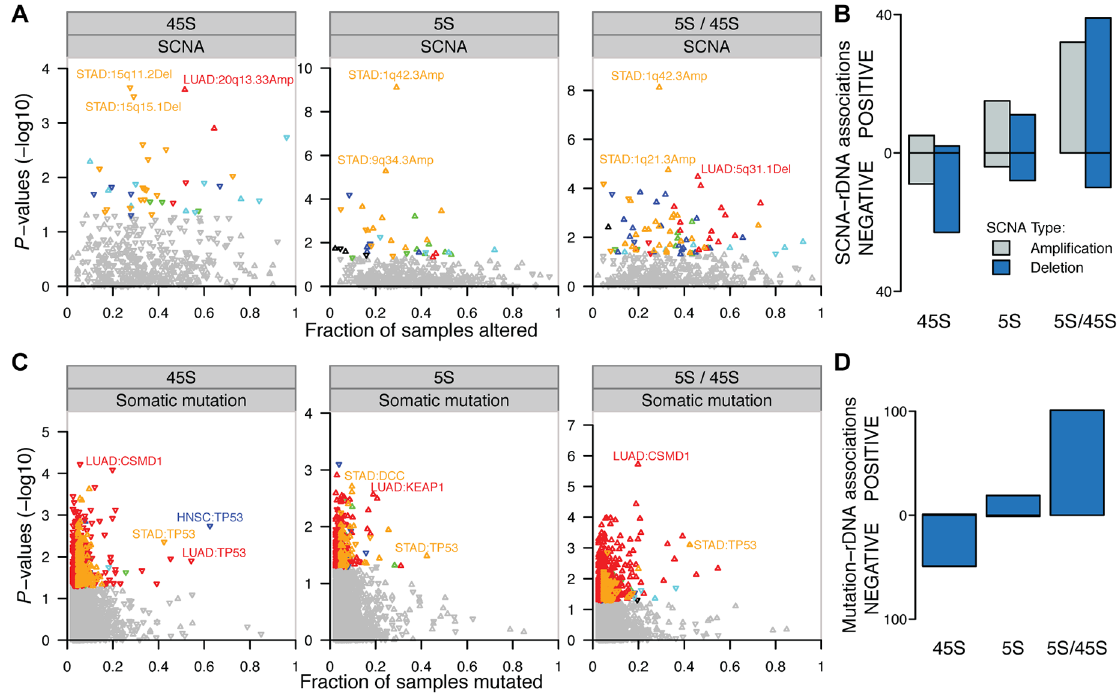
Fig 4. Association between genetic context and rDNA CN alterations. (A) Associations betweencopy numberalterations (SCNA) and 5S CN, 45S CN and 5S/45S ratio. (B) Significantlyassociated rDNA-SCNA pairs ( P < 0.05) are preferentially implicatedin greater 45S loss and greater 5S rDNA amplification ( P < 0.05, binomialtest). (C) Associationbetweensomatic mutations and 5S CN, 45S CN and 5S/45S ratio. (D) Significantlyassociatedmutation-rDNA pairs ( P < 0.05) are almost exclusivelyimplicatedin greater 45S loss and greater 5S rDNA amplification ( P < 0.001, binomialtest) in LUAD. For (B, C) Y-axis show the P-values for the associationsbetweenthe SCNA or gene mutation event and 45S CN, 5S CN and 5S/45S ratio. rDNA associationswere colored accordingto cancer type ( P < 0.05). The up/downdirectionof trianglesindicatesthat the somatic alterationis associatedwith increasedor decreasedCN or 5S/45S ratio. The X-axis shows the fraction of patients with the non- silent gene mutation or focal SCNAs (ploidy cutoff > 2.1 for amplification and < 1.9 for deletion).